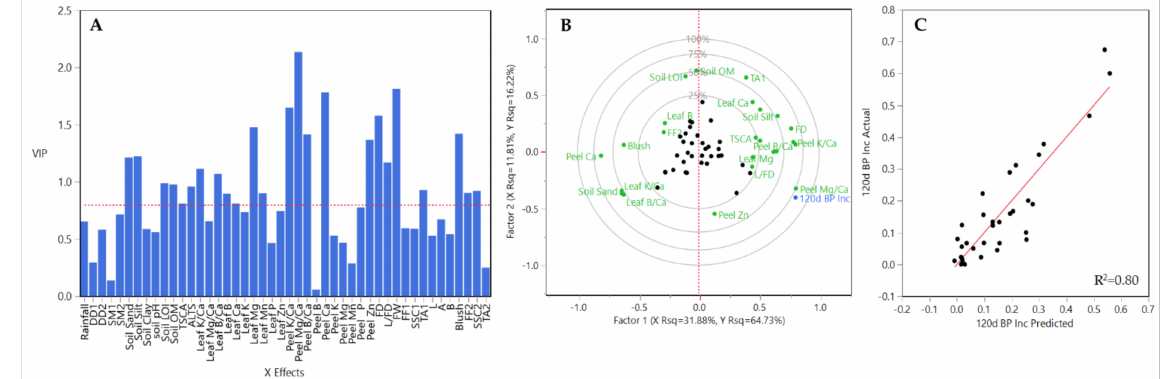
Figure 10. Results obtained from the partial least square (PLS) analysis between BP incidence at 120 DAH and the rest of variables evaluated all three years and all rootstocks together for CV. ( A ) Important X variables in the PLS model, ( B ) correlation loading plot, and ( C ) observed values versus PLSR-predicted values for BP. Abbreviations: ALTS: average